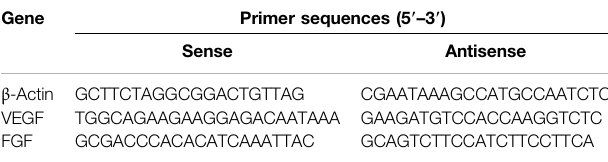
TABLE 1 | Primer sequences for